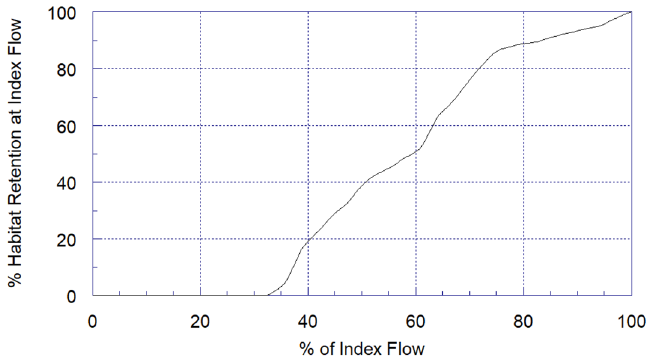
Figure 5. Habitat retention (%) at the different proportion of the base flow. For example, if we maintain 40% of the base flow, at least 20% of the GRDs’ hydro-physical habitats will have remained in the stream.